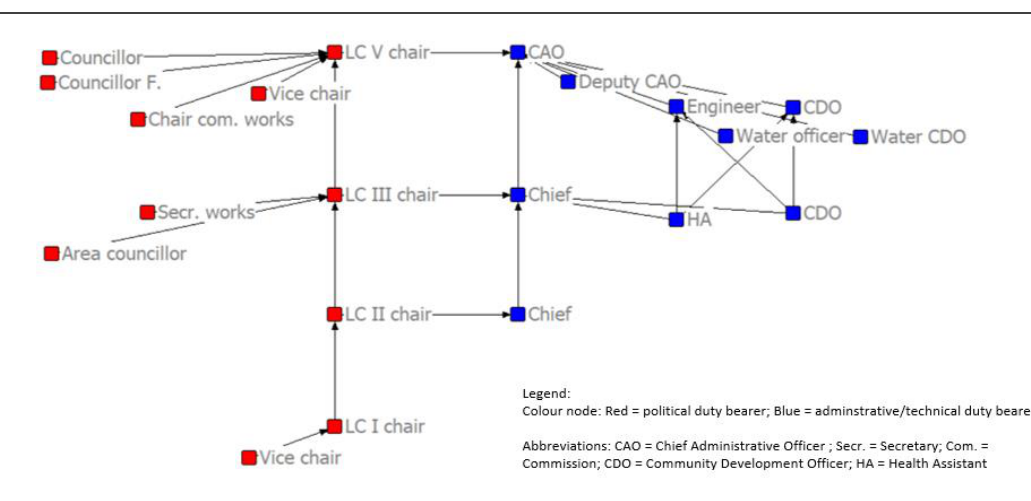
Figure 2a: Theoretical ‘reporting’ network